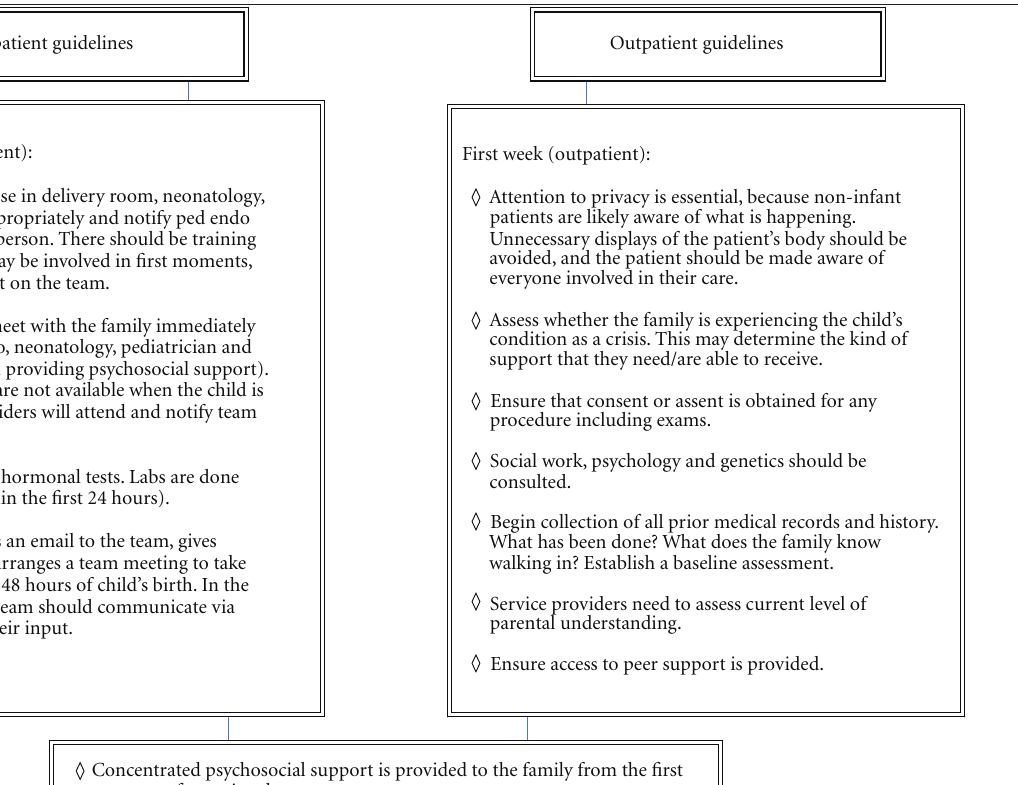
Table 3: Sample team operation